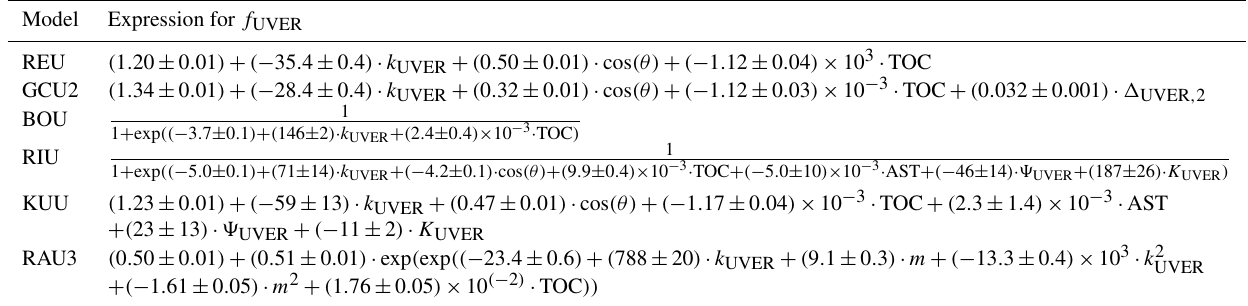
Figure 3. Mean relative residuals of each UVER diffuse fraction model vs. (a) solar zenith angle, (b) UVER transmissivity, and (c) predicted UVER diffuse fraction values. The range of the solar zenith angle (10–70 ◦ ) has been divided into six equal bins while the ranges of the k UVER (0, 0.025) and f UVER (0,1) have been split into 10 bins. The mean value for each bin (central point) and the standard deviation of the mean are shown (error bars) Table 2. Functional form of the models and empirical fitting coefficients with their corresponding standard error for Badajoz, Spain.